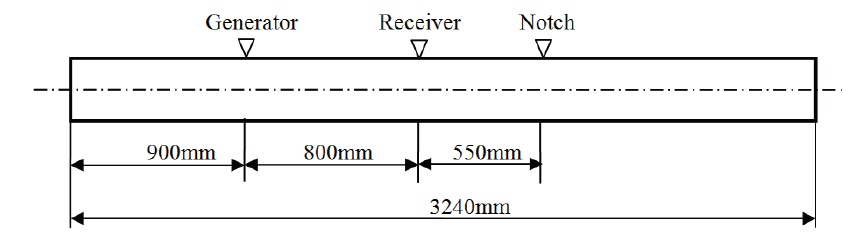
Figure 6. The photos of the sensors ( a ), the excitation coil and two bias coils ( b ), as well as the conventional receiving sensor and the prototype receiving sensor.